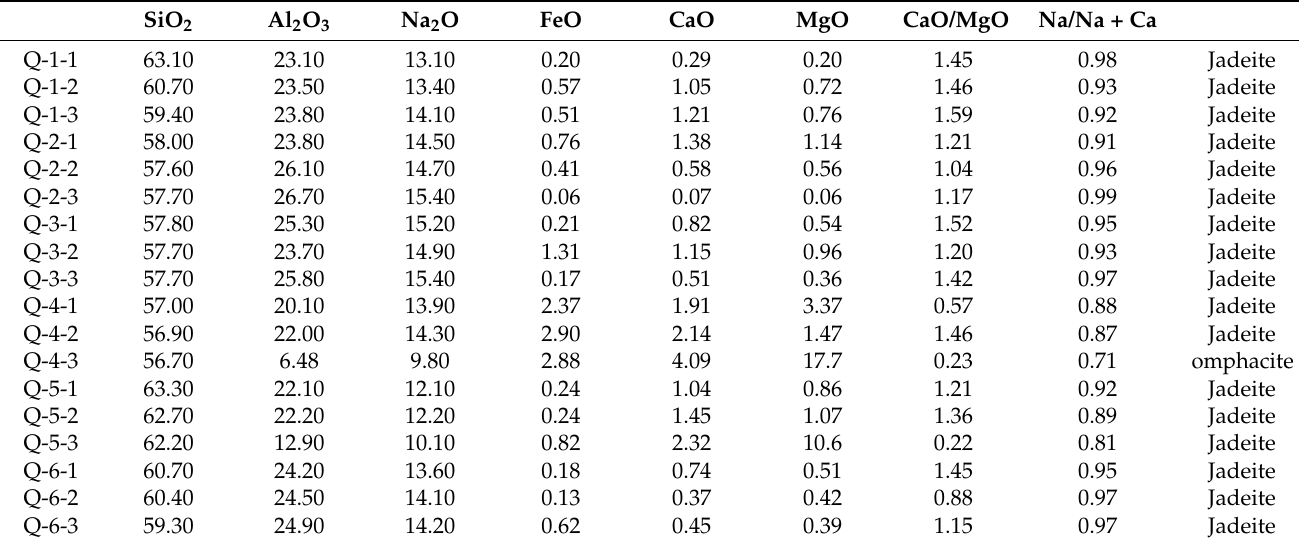
Table 2. Main chemical composition of Qing dynasty jadeite